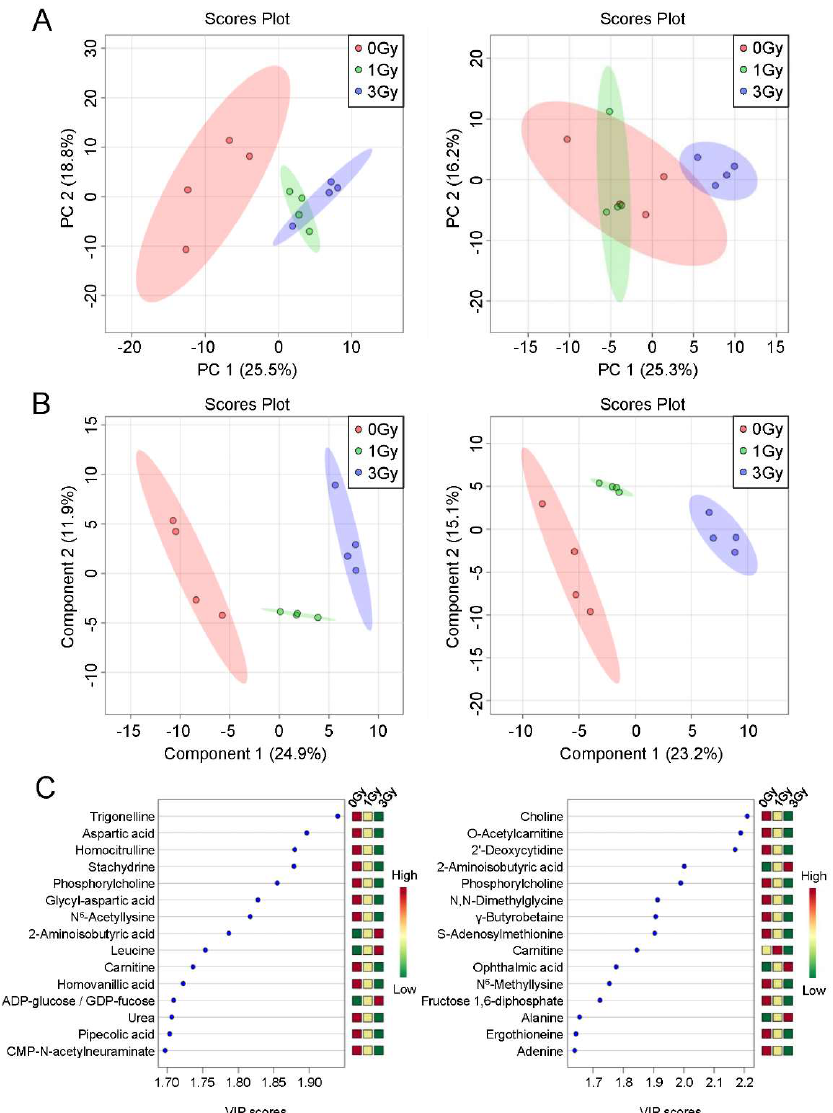
Figure 4. Multivariate data analysis of the blood cell metabolome from mice exposed to ionizing radiation. Principal component analysis ( A ) and partial least squares discriminant analysis ( B ) were performed. Circles indicate the 95% confidence interval. ( C ) Top 15 variable importance in projection (VIP) scores from partial least squares discriminant analysis of component 1. PC, principal component.